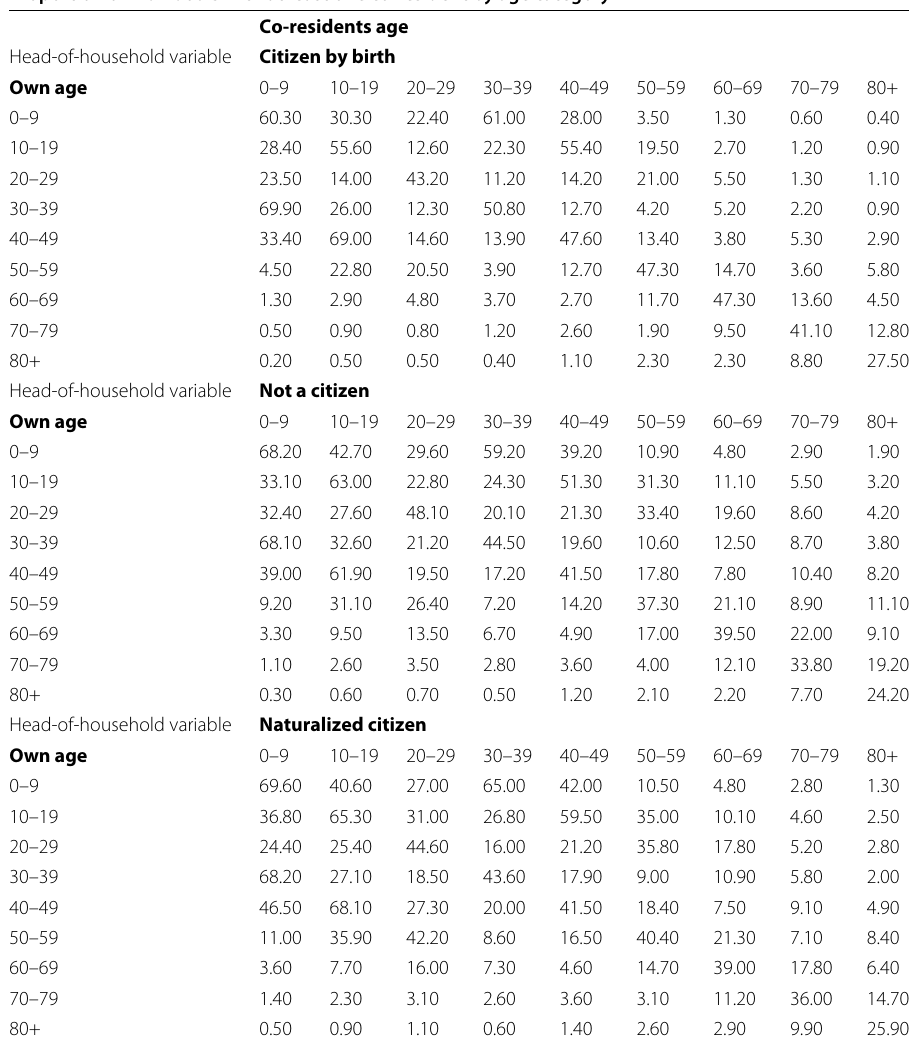
Table 10 Proportion of individuals with at least one co-resident by age and